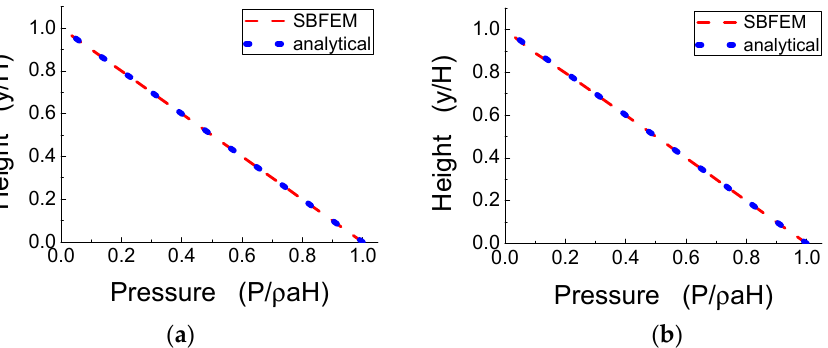
Figure 14. Triangular valley with vertical excitation: ( a ) along line AB and ( b ) along line AC.